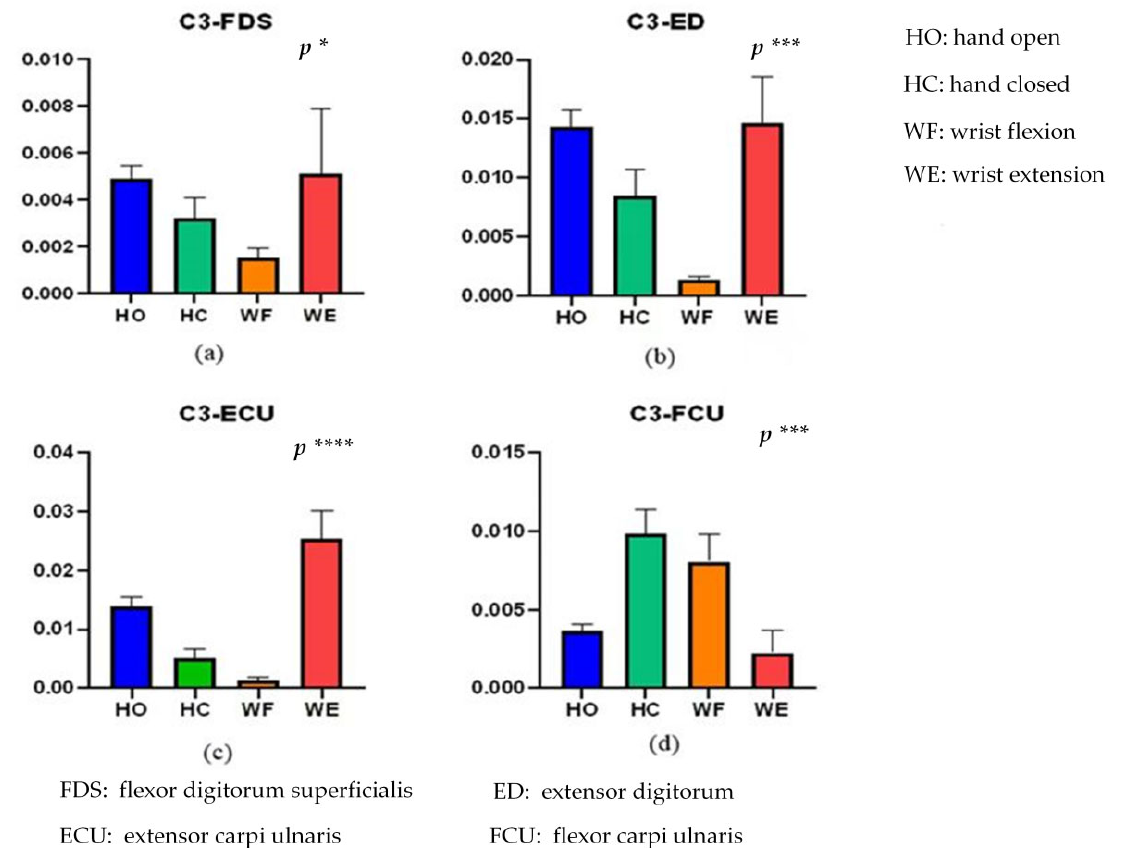
Figure 5. Kendall rank correlations of ( a ) C3-FDS, ( b ) C3-ED, ( c ) C3-ECU, and ( d ) C3-FCU for the four different activities. ( * means p < 0.05, *** means p < 0.001, **** means p < 0.0001). HO: hand open, HC: hand closed, WF: wrist flexion and WE: wrist extension.